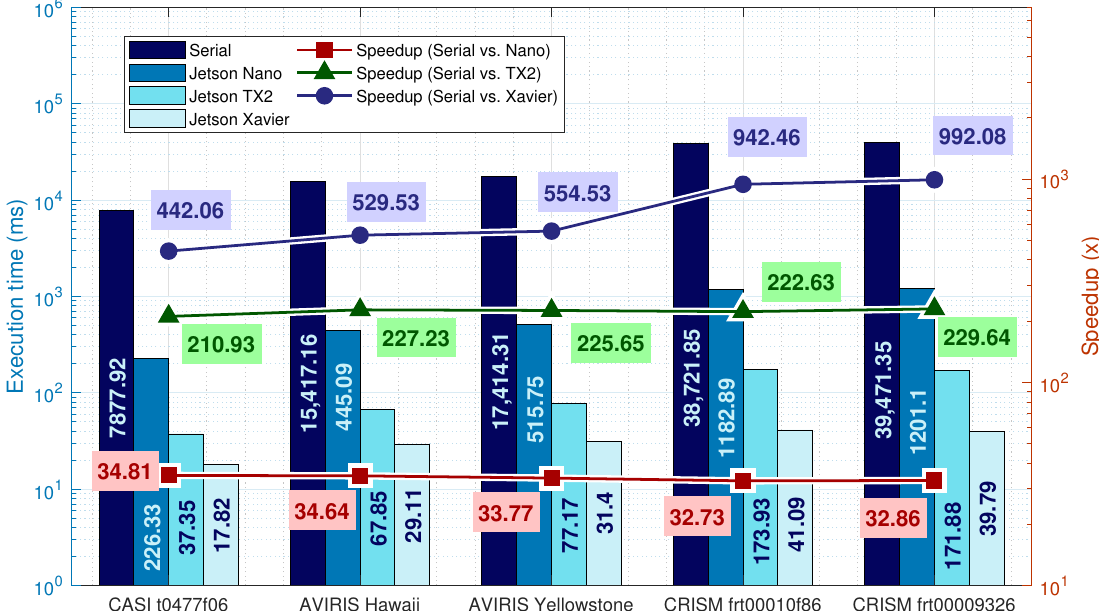
Figure 3. CCSDS-123 parallel predictor implemented on the GPU for p = 0. The bars represent execution time while the lines represent speedup relative to serial execution time running in a single-core on the Nano system (For the CRISM images, the Nano executes half of the bands for the predictor and both encoders due to memory restrictions. The presented values are multiplied by two to simulate the full image